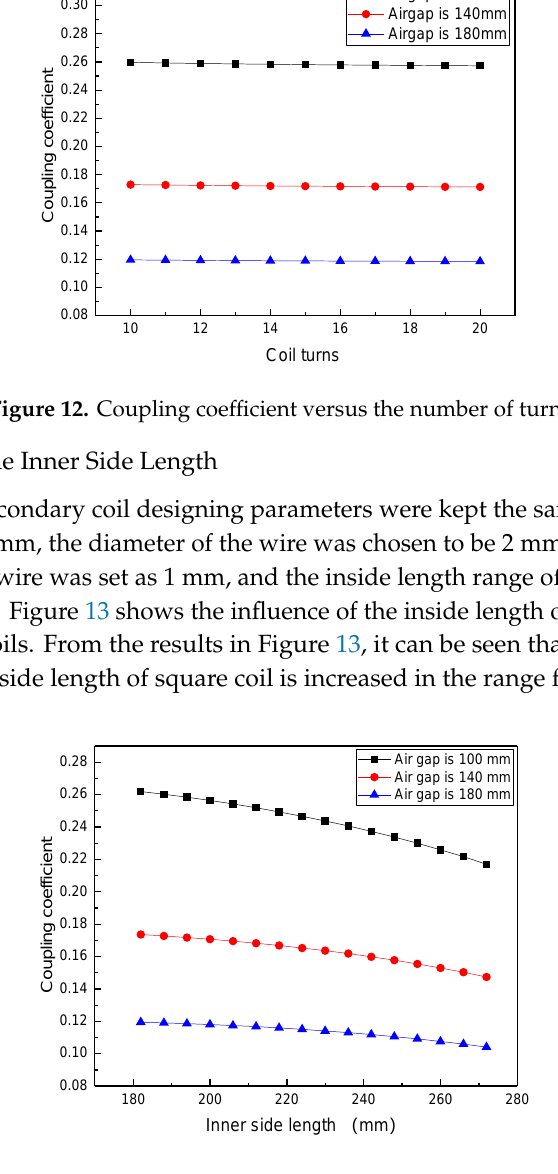
Figure 13. Coupling coefficient versus the inner side length.